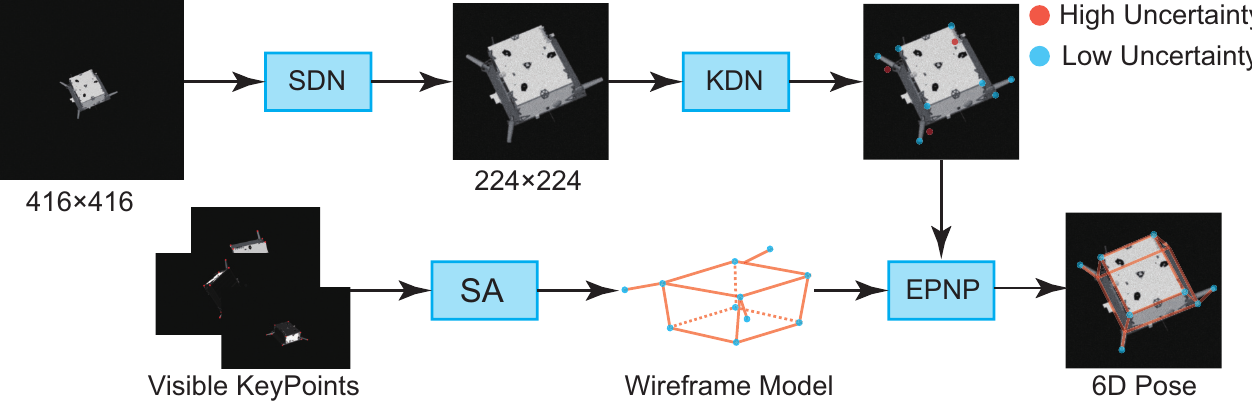
Figure 2. The pipeline of our proposed method to estimate the 6D pose of a spacecraft from a monocular image. SDN: Spacecraft Detection Network. KDN: Keypoint Detection Network. SA: Simulated